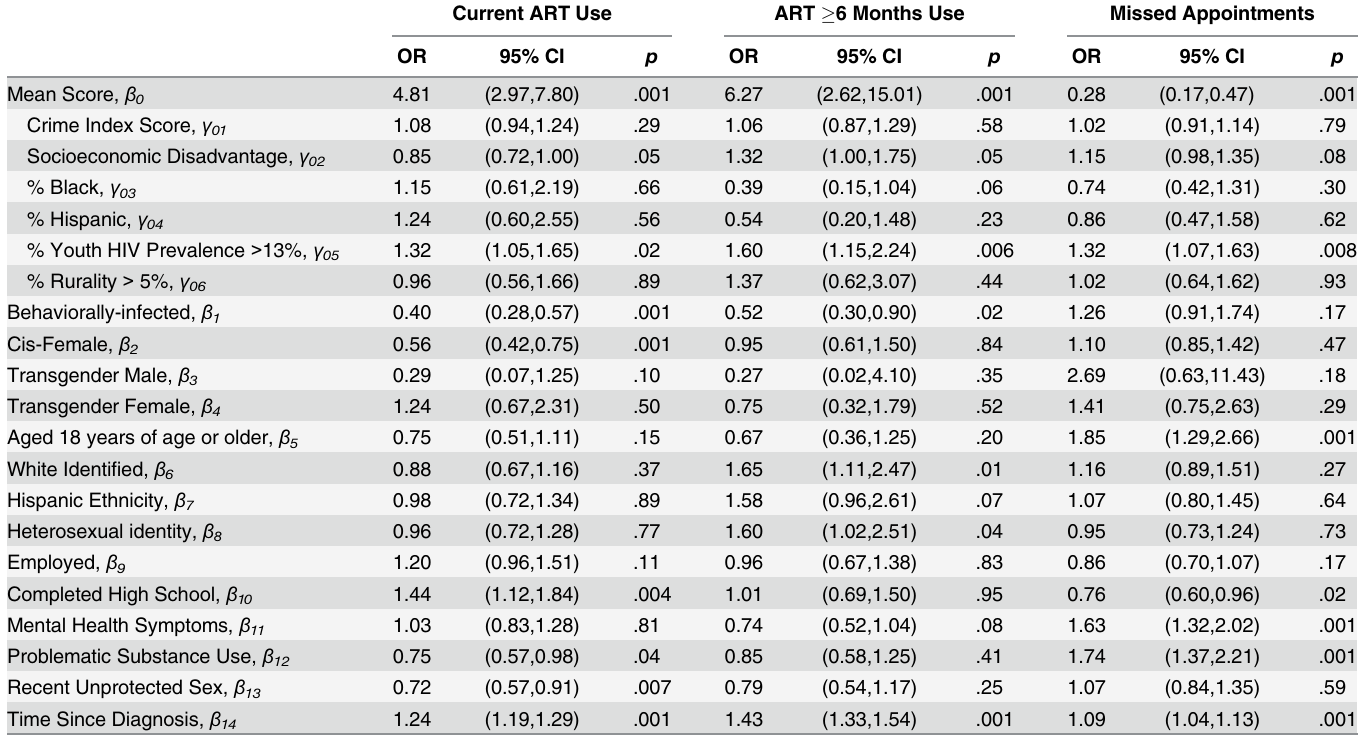
Table 4. Multi-level Associations between Current ART Use, (cid:1) 6 Month ART Use, and Missed HIV Care Appointments and Structural- and Individ- ual- Level